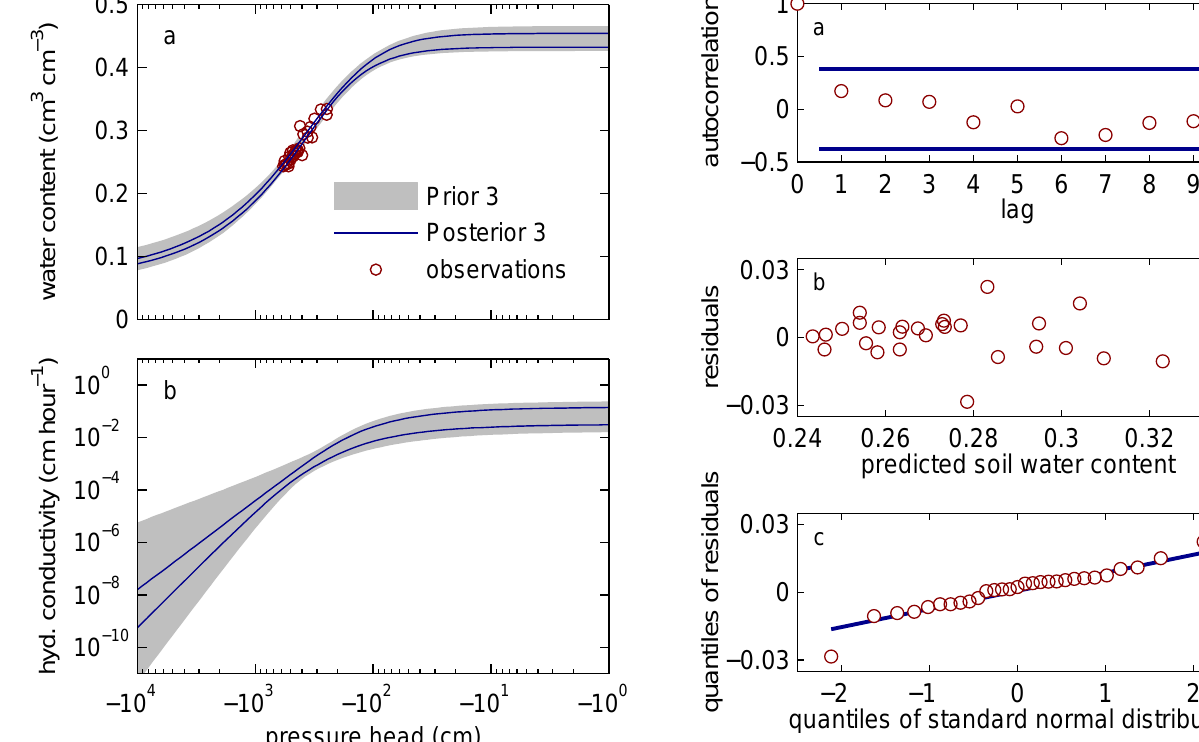
Fig. 9. 95% prior and posterior uncertainty bounds of (a) the water retention function and (b) the hydraulic conductivity function using real soil water content data and the prior probability distribution with correlation among the soil hydraulic parameters (Prior 3). In addition, the actual soil water content observations are plotted.